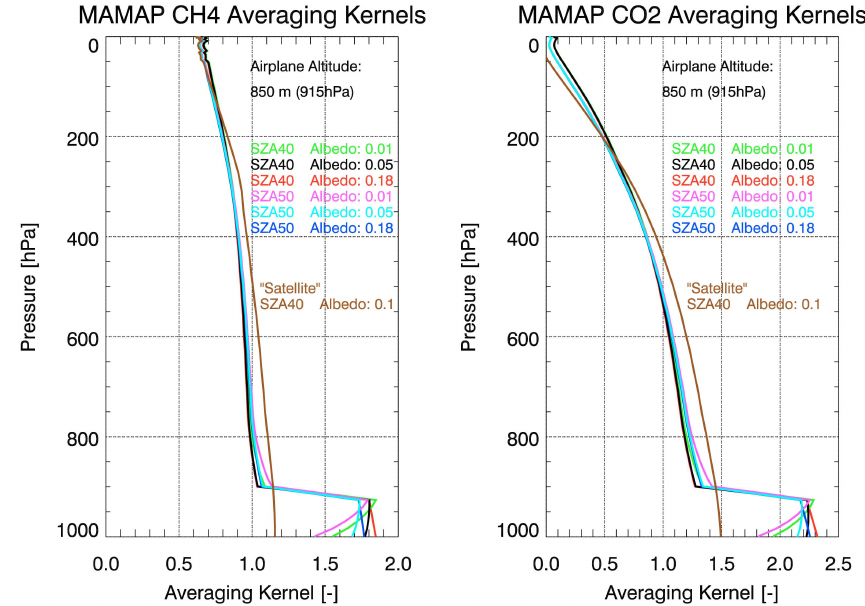
Fig. 6. Averaging kernels for the MAMAP instrument depending on solar zenith angle (SZA) and surface albedo/SSR for a nadir measure- ment at 850m flight altitude. The figure shows the striking difference of the averaging kernels below the instrument compared to above the instrument. This difference is due to the fact that for a nadir viewing instrument light coming from the sun passes through the absorber below the aircraft twice (once before and once after reflection at the surface). Left: averaging kernels for CH 4 ; right: averaging kernels for CO 2 .